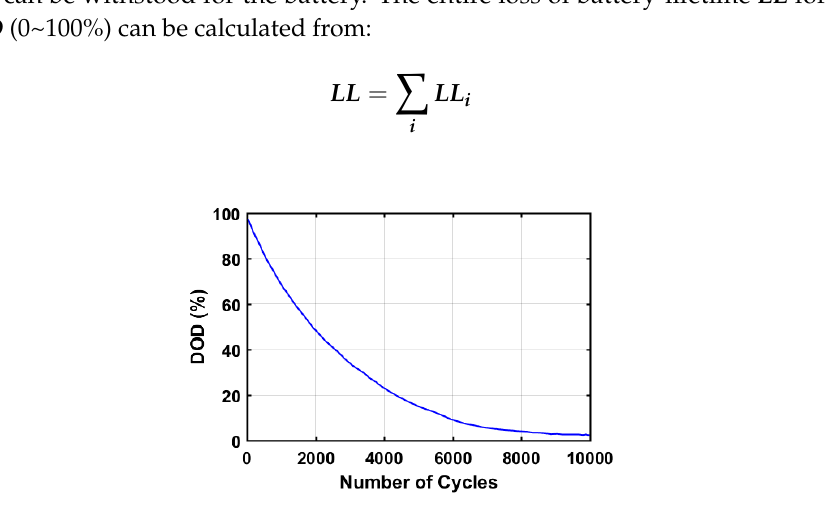
Figure 8. Wöhler curve for a lead-acid battery [30,31].